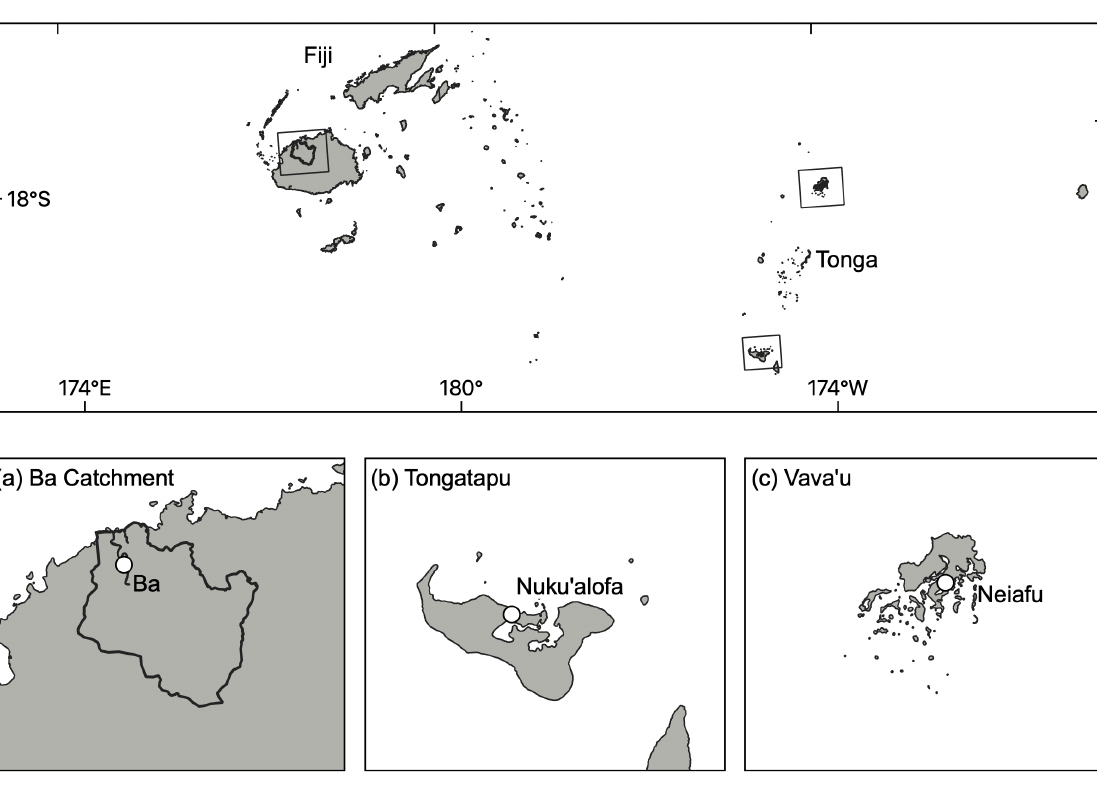
Figure 1. The tool is being co-developed with stakeholders in the (a) Ba Catchment, Fiji, (b) Tongatapu, Tonga and (c) Vava’u, Tonga.